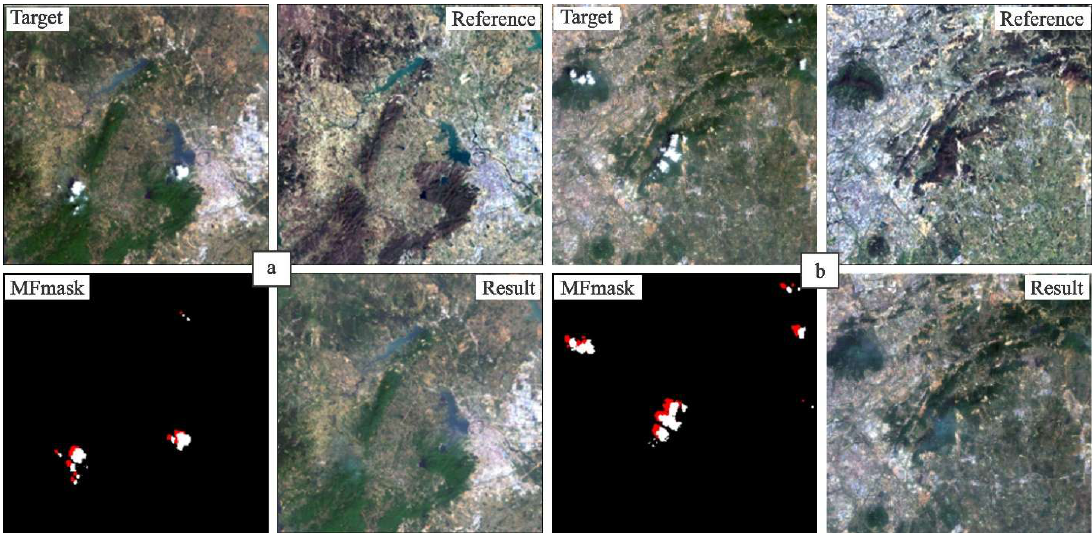
Figure 7. Applying the LRM approach to the OLI image located in Southeast China near Nanjing City. ( a ) The target image captured on 29 April 2016 with five subset test areas (bands 4, 3 and 2 composited) containing different land cover patterns. ( b )–( c ) The reference images acquired on 28 March and 12 March 2016 were used to reconstruct the cloudy areas.